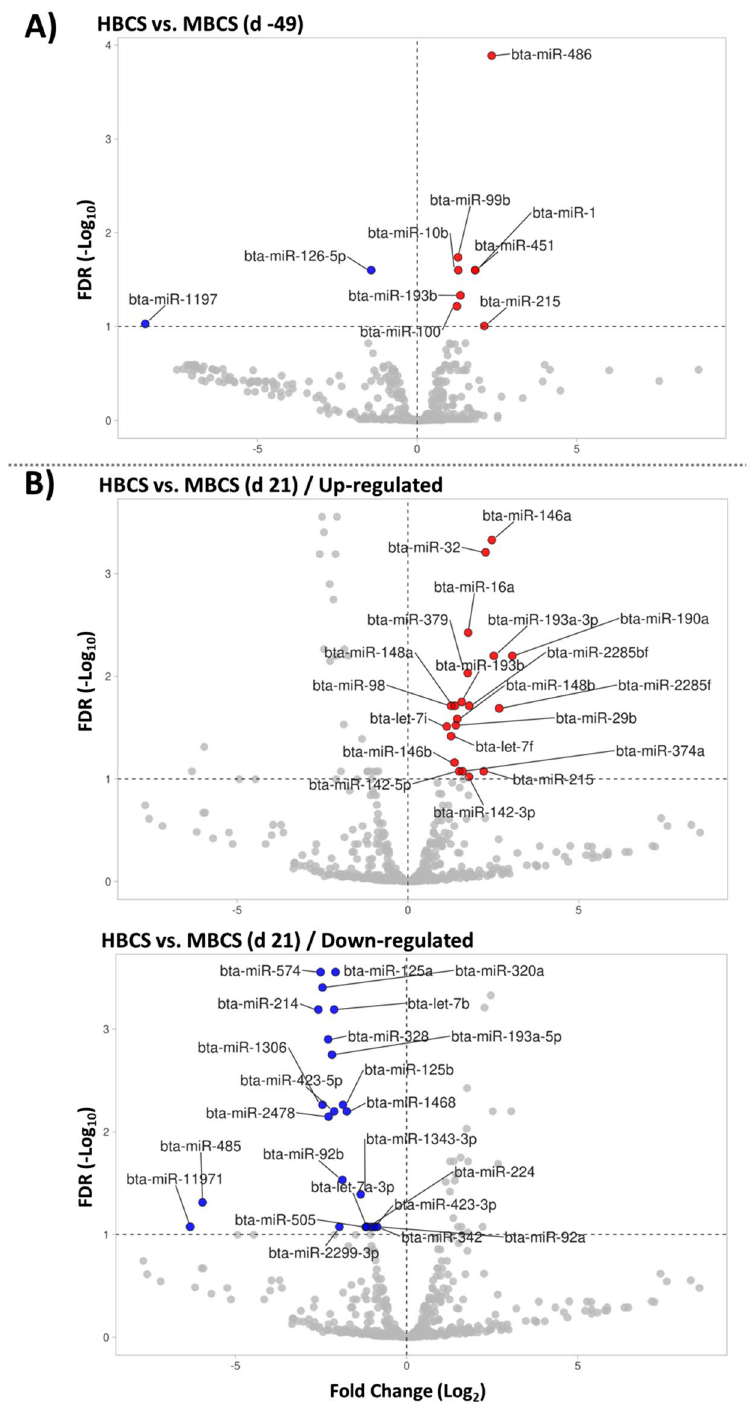
Figure 1. Volcano plot visualizing subcutaneous adipose tissue miRNA that were differentially expressed between high-conditioned (HBCS) and moderate-conditioned (MBCS) dairy cows on ( A ) d -49 and ( B ) 21 relative to calving. The horizontal line represents the negative logarithm of the adjusted P -value (FDR = 0.10). Red points show the upregulated expressed miRNA in HBCS versus MBCS cows and blue points show the downregulated